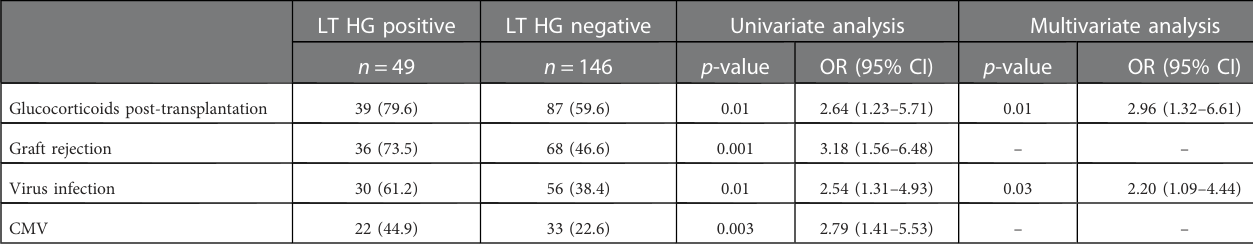
TABLE 4 Uni and multivariate analysis for LT cohort